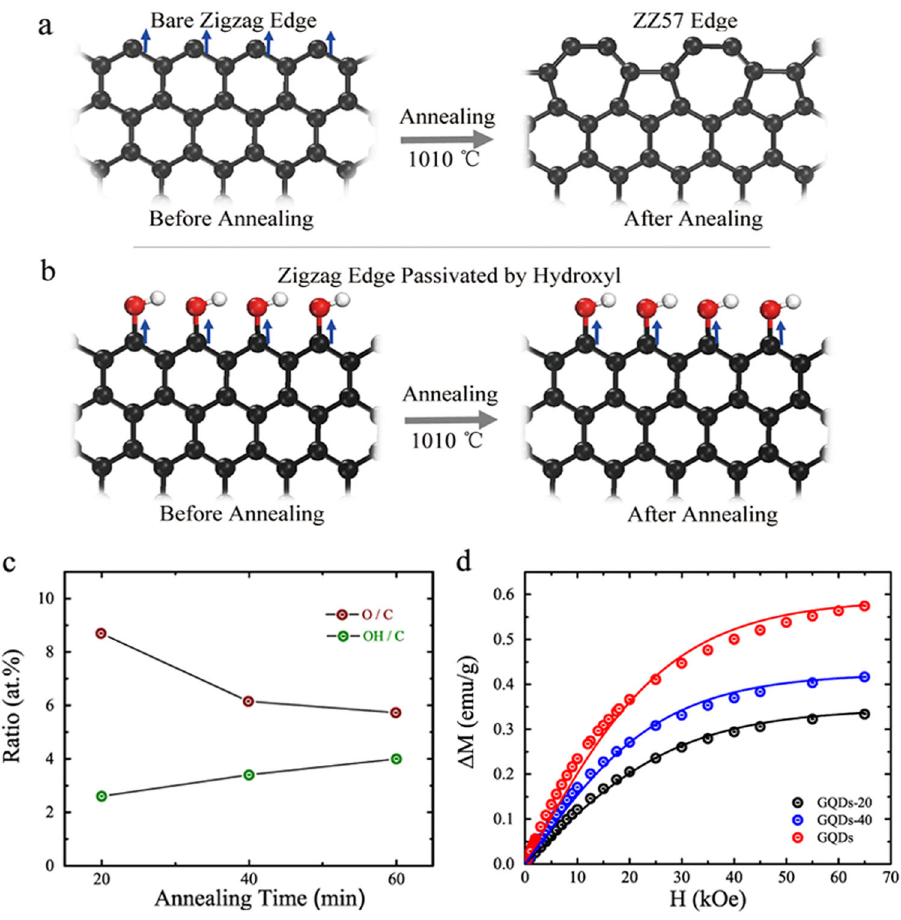
Fig. 5 Schematic illustrations of a bare zigzag edge, b zigzag edge with σ bonds passivated by hydroxyl groups, before and after annealing at 1010 °C. c Dependences of oxygen to carbon ratio (O/C, wine dots ) and OH coverage (OH/C, green dots ) measured or calculated according to the XPS spectra on the annealing time. The lines shown are guides to the eyes only. d Δ M – H of GQDs-20 ( black dots ), GQDs-40 ( blue dots ) and GQDs ( red dots ) samples measured at 2 K. The round symbols are the measurements and the solid lines are fi t to Brillouin